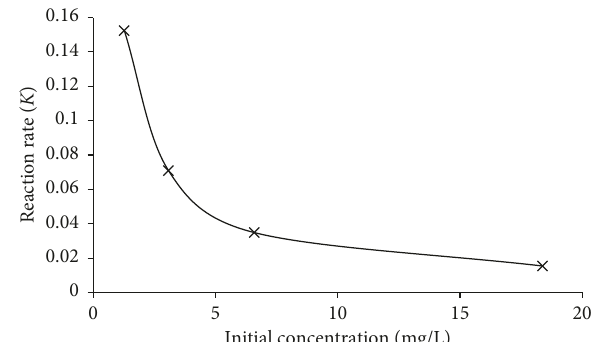
Figure 6: Plot of the bulk decay rate constant K against the initial chlorine dose